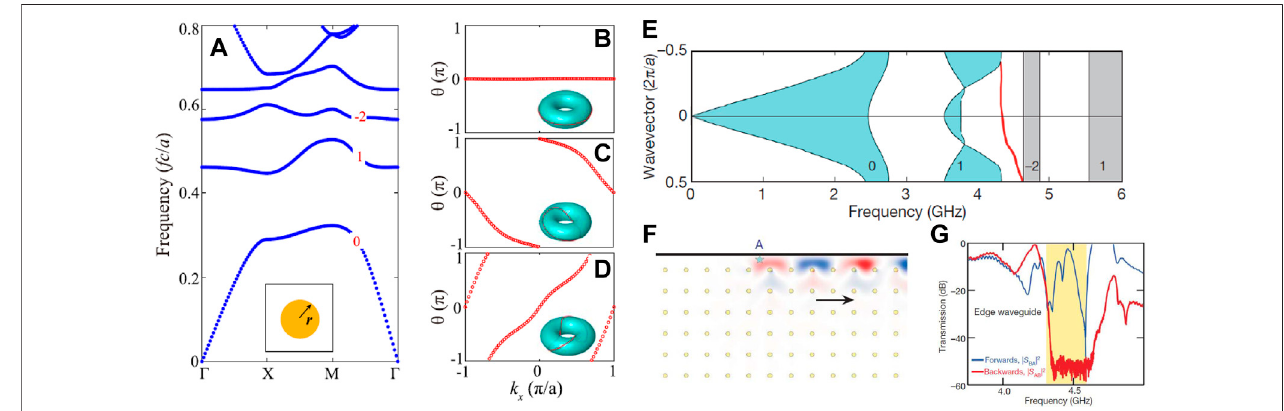
FIGURE 3 | PhotonicanalogofCherninsulators[27,63]. (A) Photonicbandstructurewithappliedmagnetic fi eld.TheChernnumberofeachbandislabeledinred.(B – D)The evolution of the Berry phase of (B) the fi rst, (C) the second, and (D) the third photonic band as the functions of k x . The winding number of the Berry phase gives the Chern number. ReproducedpermissionfromRef.27. (E) CalculatedprojectedphotonicbandstructurewiththechiraledgestateexitsattheinterfacebetweenthemetalcladdingandthePhC. (F) Chiral edgestate fi elddistribution,whichradiatesonlytotherightalongmetalcladding. (G)